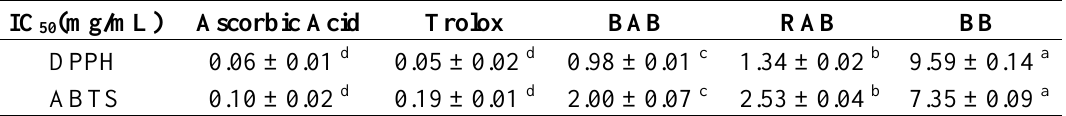
Table 1. IC 50 values of the bean extracts, as determined by DPPH and ABTS + assay. IC 50